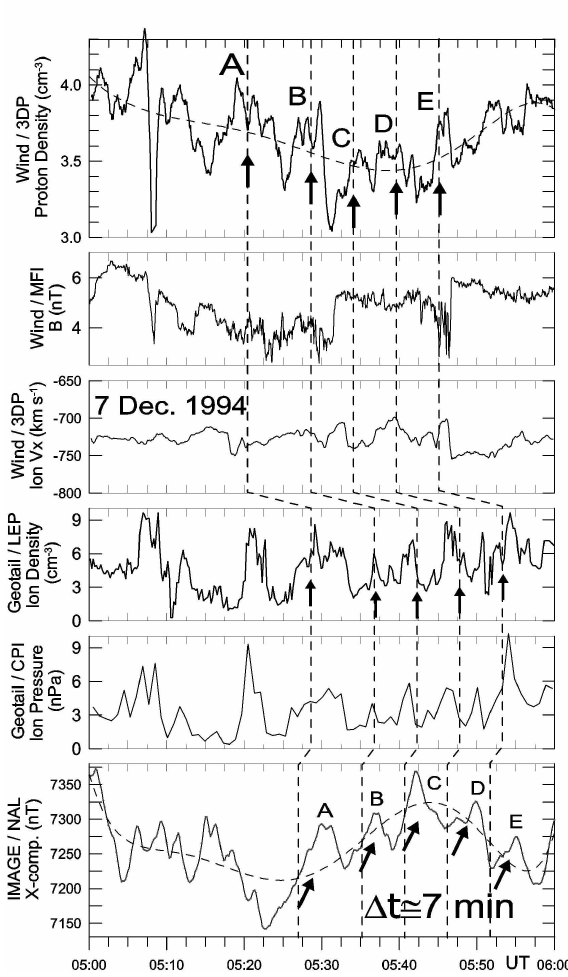
Fig. 10. From top to bottom, proton density (cm − 3 ) , magnetic field amplitude (nT) and ion velocity V x (km · s − 1 ) measured by Wind, ion density and pressure (nPa) measured by Geotail, and X compo- nent variations recorded by NAL. The variations marked with the capital letters A–E along the NAL trace are probably dictated by distinct solar wind density increases.